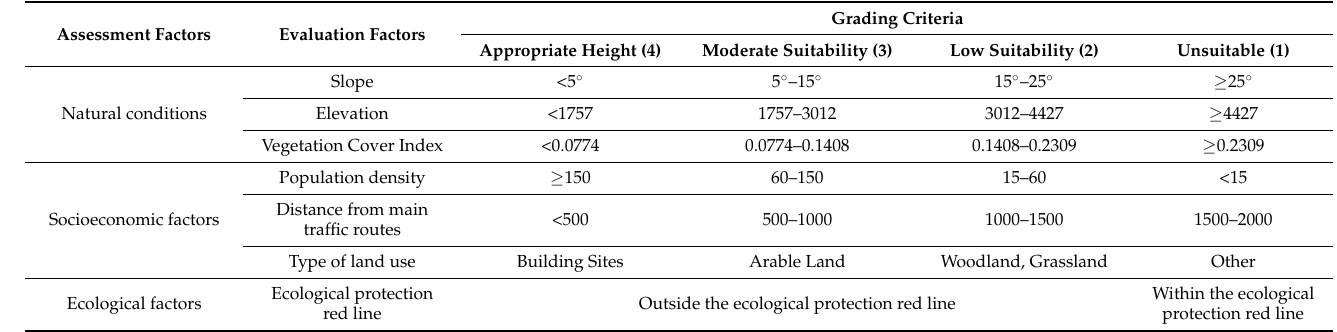
Table 2. Suitability evaluation index system of construction